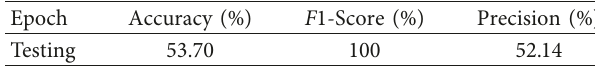
Table 12: Test results using dataset I.